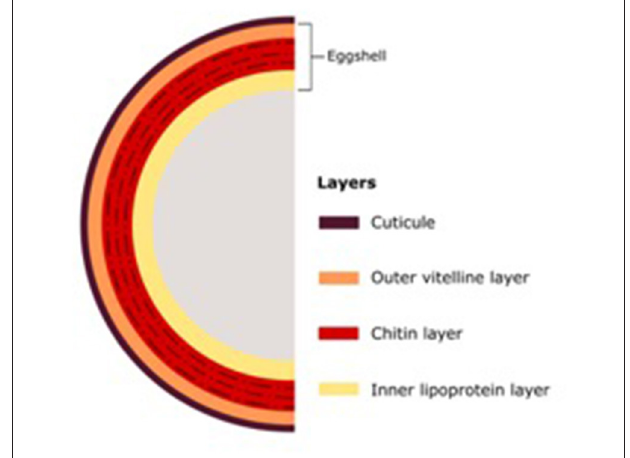
FIGURE 1 | The structure of eggshell